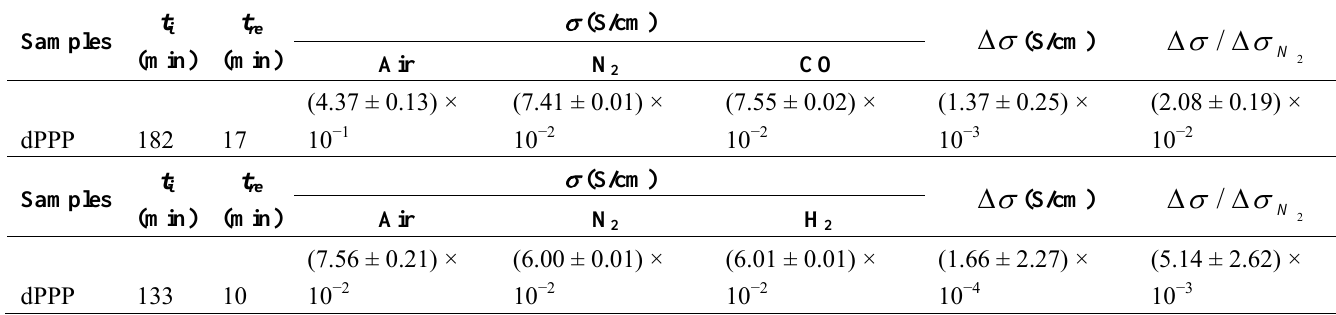
Table 3. Doped PPP samples (dPPP) with their electrical conductivity responses, sensitivities, and temporal responses towards CO, and H